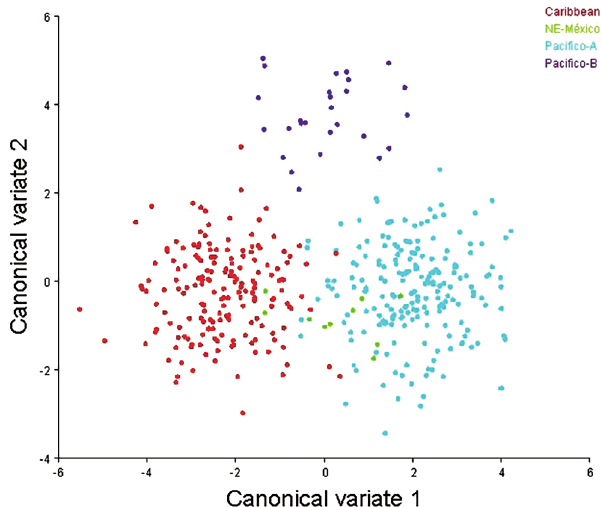
Fig. 6. Two-dimensional ordination based on Canonical variate analysis (CVA) of Agonostomus monticola specimens from the four